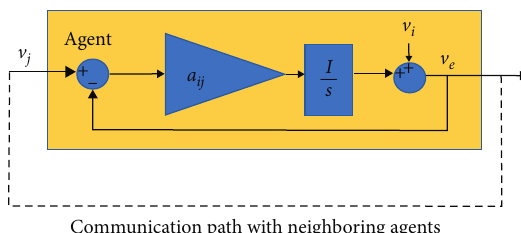
Figure 9: Consensus-based control diagram. This diagram shows how consensus-based algorithm is used for voltage